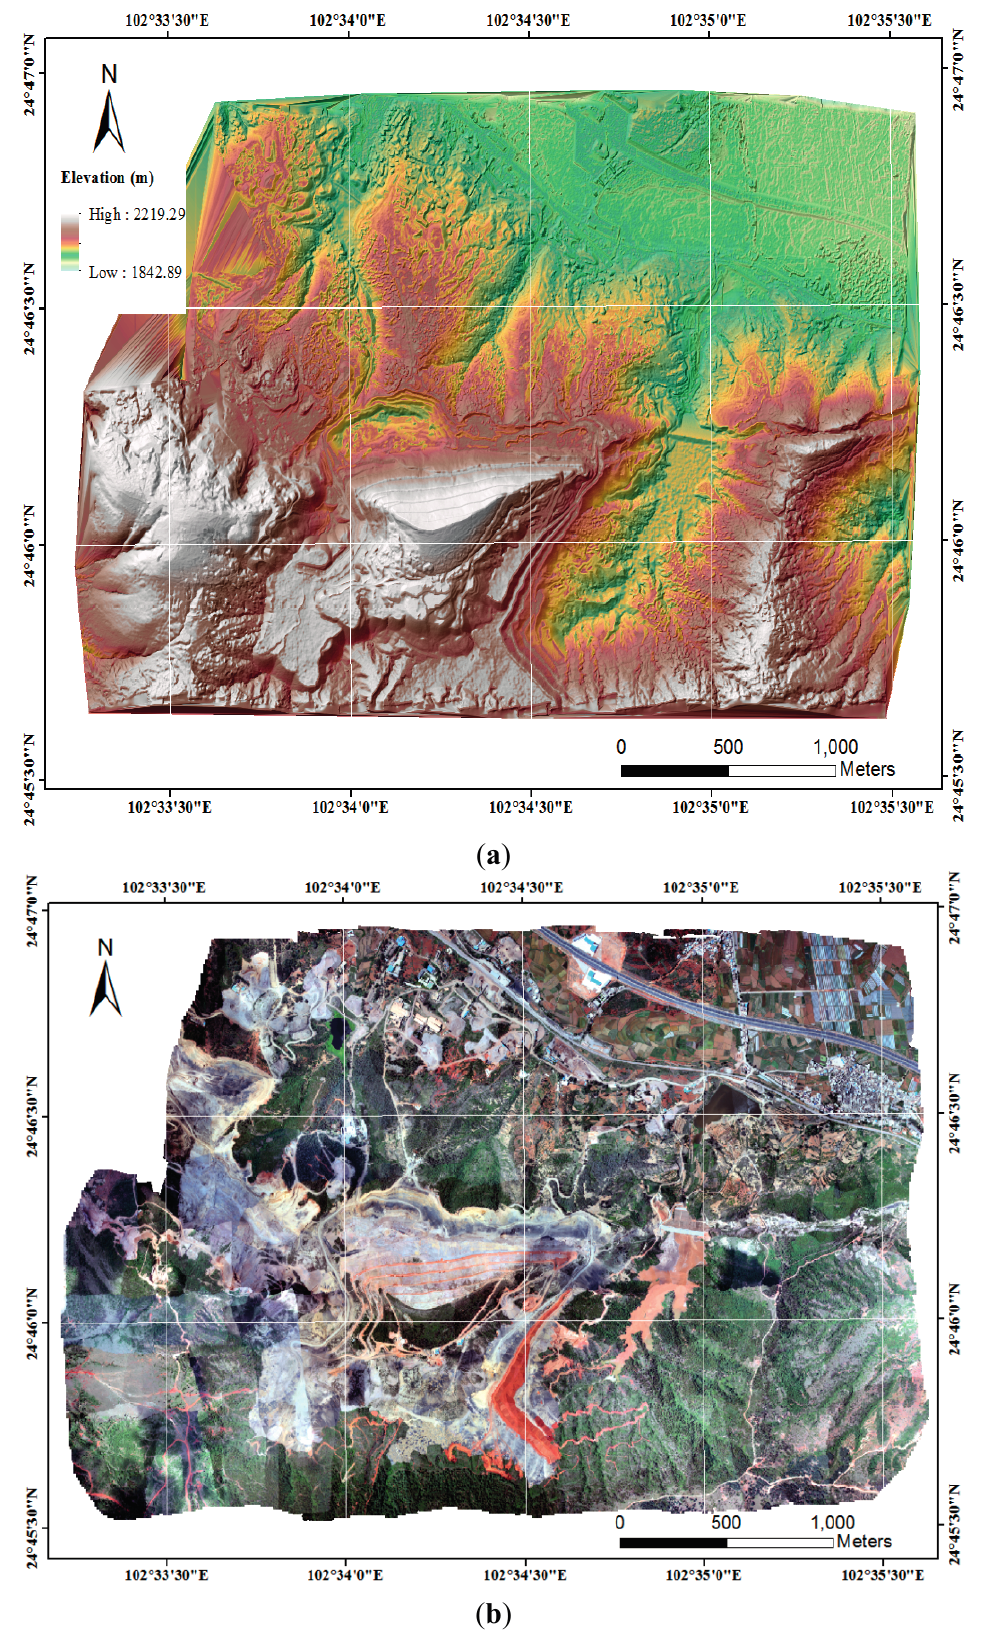
Figure 7. Result of the generated. (a) Hill-shaded DSM (with a cell size of 2 m) and (b) the generated DOM (with a spatial resolution of 0.15 m) in Jianshan